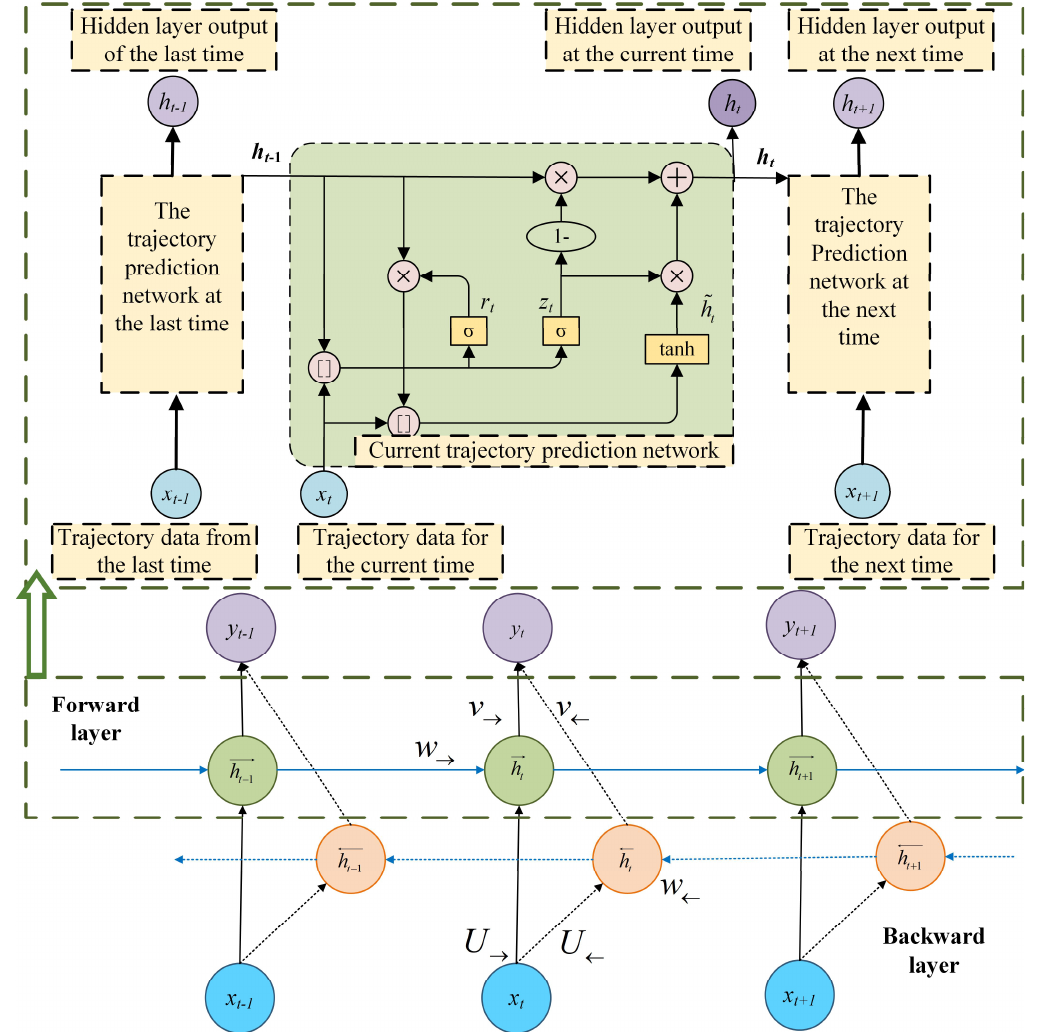
Figure 3. BiGRU structure.